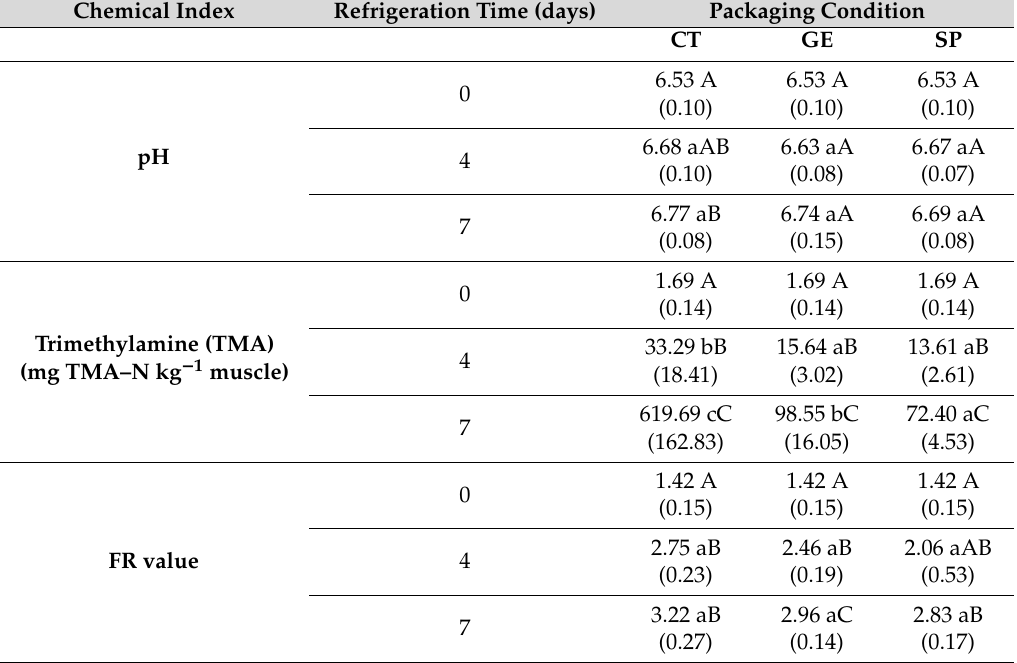
Table 3. Determination of di ff erent chemical quality indices * in mackerel muscle stored under di ff erent packaging conditions